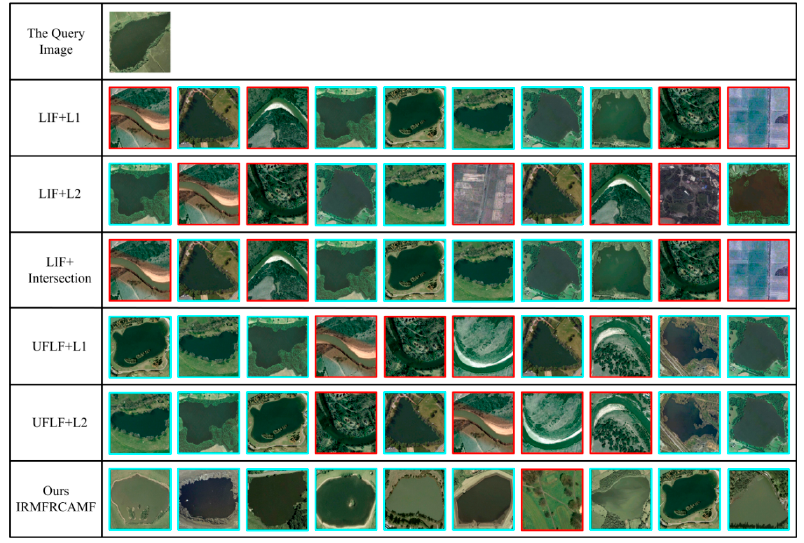
Figure 13. Visual illustration of the retrieved images using different methods when the query image comes from the pond class. The red rectangles indicate incorrect retrieval results, and the blue rectangles indicate correct retrieval results.